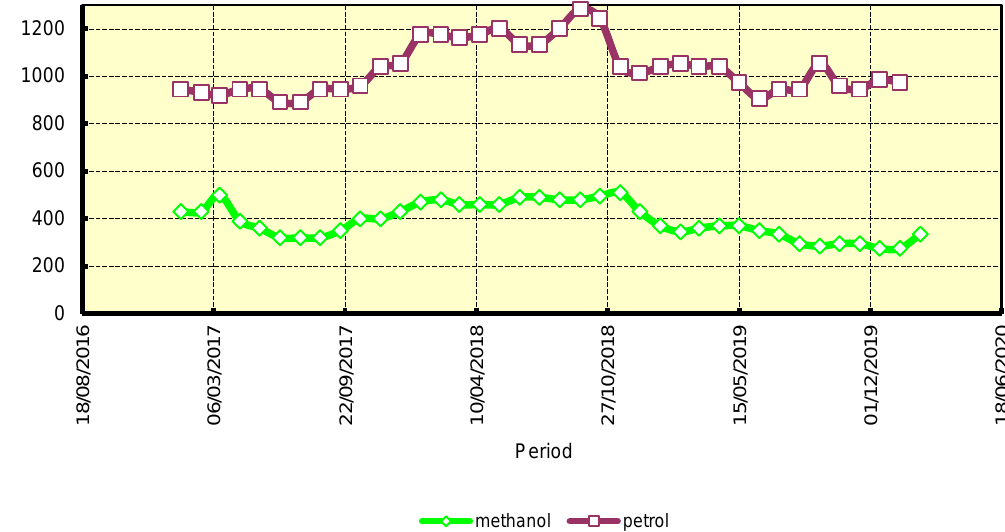
Figure 7. Selected fuel prices.